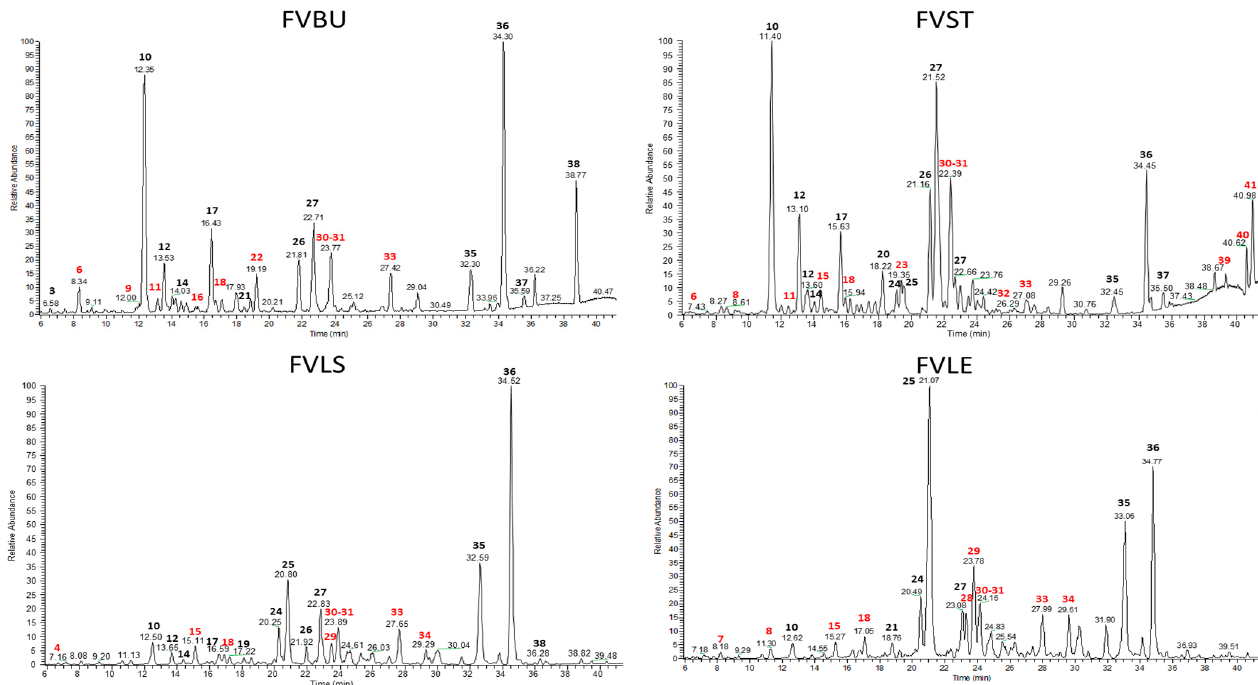
Figure 1. Negative ion mode profiles of F. vulgare waste ethanolic extracts obtained by LC ‐ ESI/LTQ/Orbitrap MS: FVBU ( Foeniculum vulgare Bulb), FVST ( Foeniculum vulgare Stem), FVLE ( Foeniculum vulgare Leaf) and FVLS ( Foeniculum vulgare Little Stem). The compounds marked in red were identified only in the ethanolic extracts and not in the decoctions.